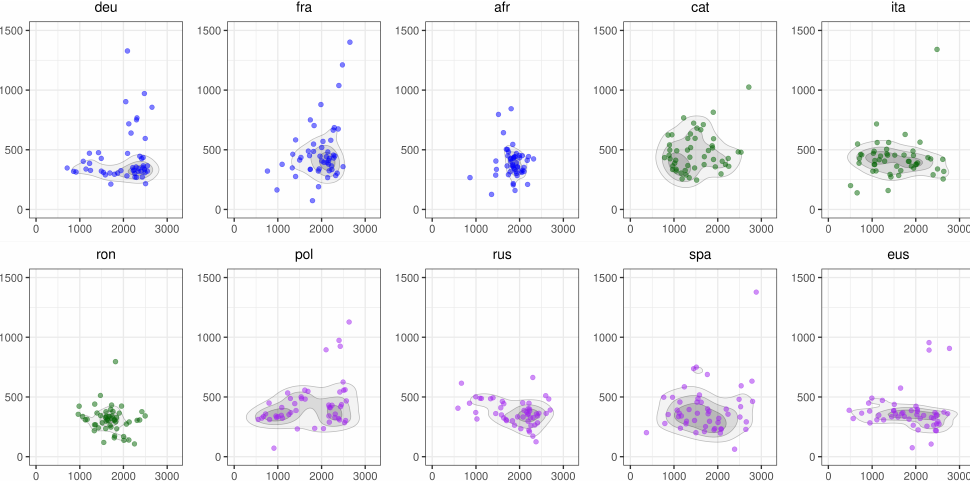
Figure 5. The distribution of formants for the vowel [u] across the 10 languages of the data set. The x-axis represents F2 and the y-axis indicates F1. The labels on the top of each sub-figure refer to the iso code of the 10 languages in the data set. The colors indicate the group to which the language is affiliated with in terms of number of timbres: blue = large, green = medium, purple =